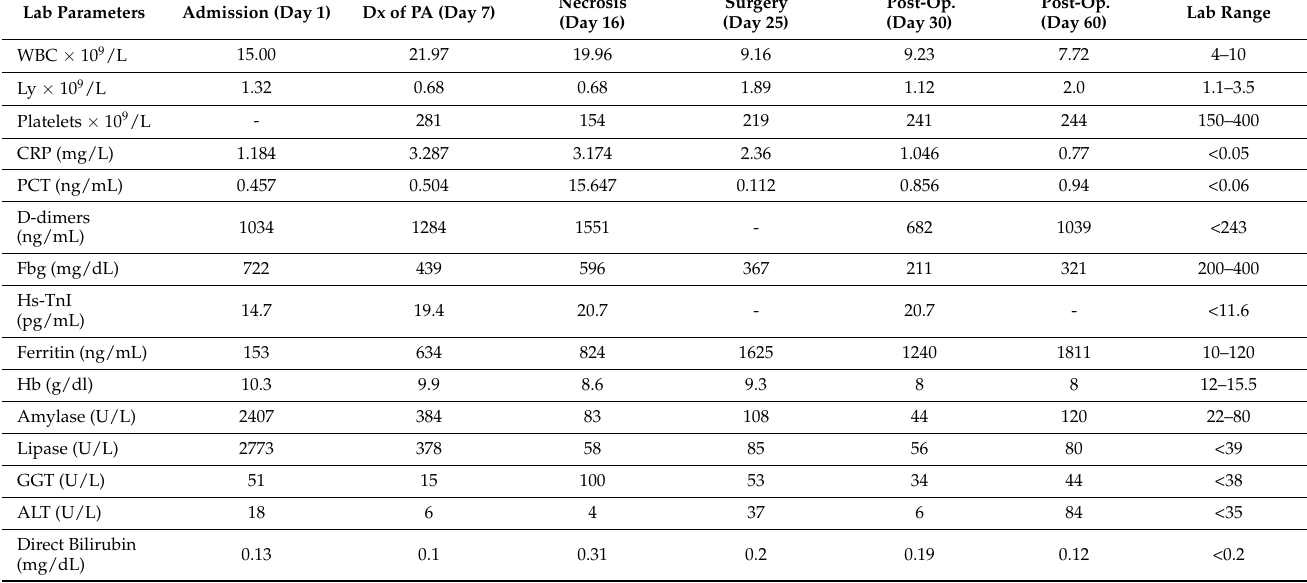
Table 1. Serological parameters and values over time, from admission to day